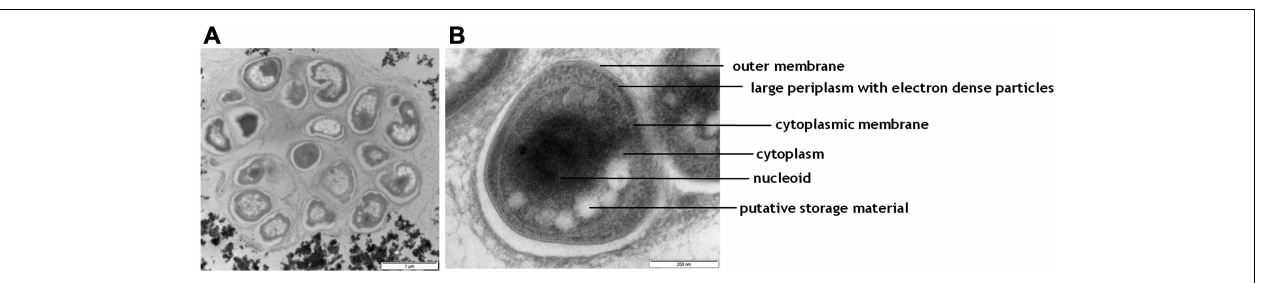
FIGURE 3 | Phylogenetic tree showing the positions of the enriched North Sea NOB and North Sea time series clone sequences (bold) in relation to known Nitrospira sequences and related sequences from the NCBI database. This unrooted bootstrap (1000 replicates) consensus tree was inferred using the neighbor-joining algorithm.Total of 1013 nucleotides were considered in the alignment. Bootstrap values are shown at the internal nodes.The scale bar is in the unit of the number of base substitutions per site. For the